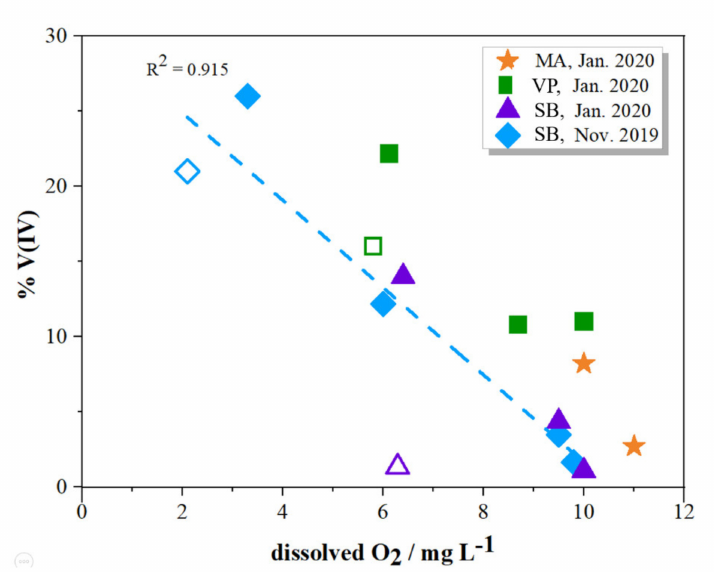
Figure 6. Percentage of reduced species in the water column of MA (orange markers), VP (green markers) and SB (purple markers—January 2020; blue markers—November 2019) sampling stations in relation to the dissolved oxygen concentration. Empty markers represent bottom seawater layer for each sampling